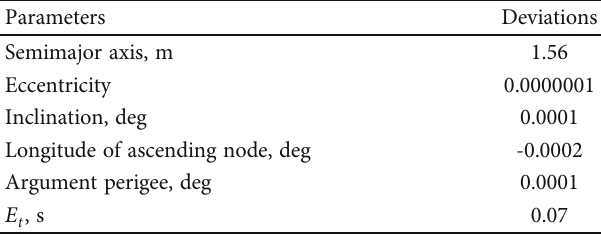
Table 5: Deviations of terminal orbital elements.